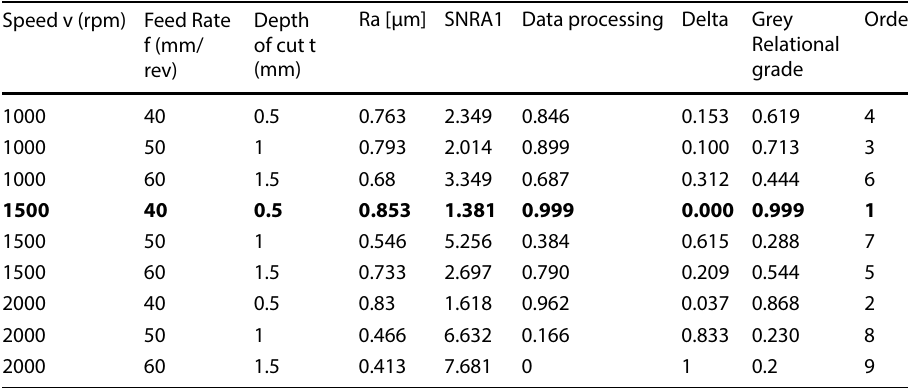
It represents the Optimized value and hence it requires